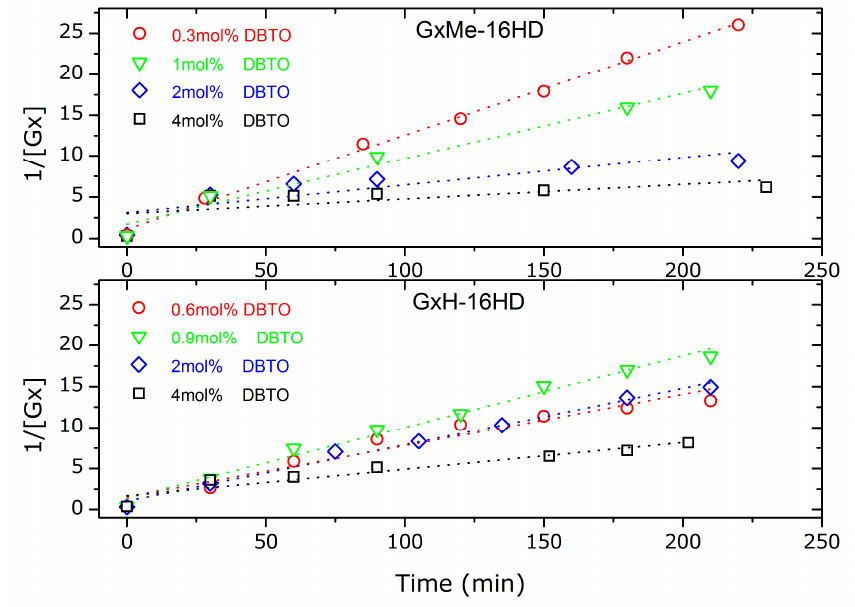
Figure 5. Kinetic plots for second order fitting of the GxMe-16HD, respectively, GxH-16HD transesterification reactions at different DBTO concentration: 0.3, respectively, 0.6 mol %; 0.9 respectively 1 mol %; 2 mol %; 4 mol %.